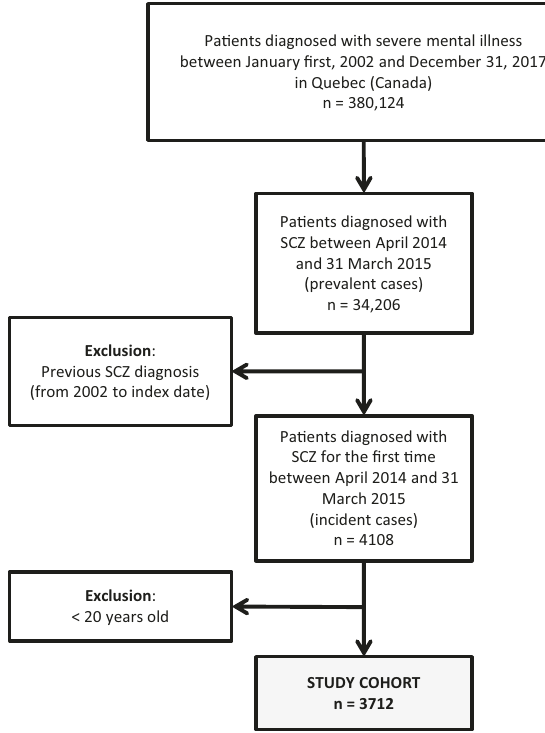
Fig. 1 Study cohort fl ow diagram.